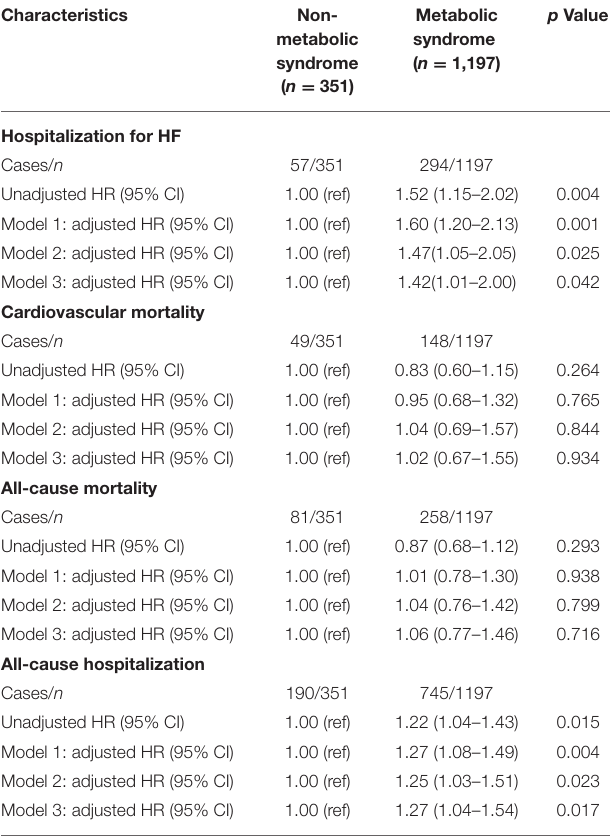
TABLE 2 | The risk of HF hospitalization, cardiovascular mortality, all-cause mortality and all-cause hospitalization in HFpEF patients with and without metabolic